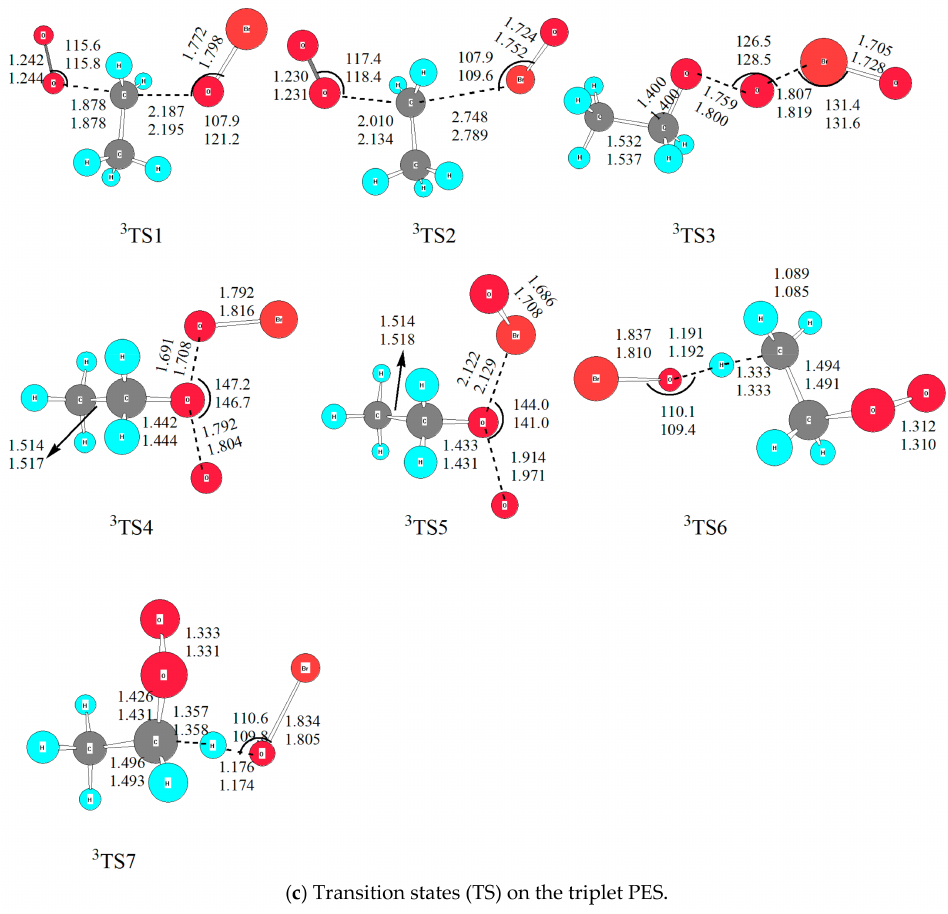
Figure 1. The optimized geometries for all species in the C 2 H 5 O 2 + BrO reaction at B3LYP/6-311++G(d,p) and B3LYP/6-311++G(2df,2p) levels. Bond distances are in Å and bond angles are in degrees. The upper one is from B3LYP/6-311++G(2df,2p); and the lower one is from B3LYP/6-311++G(d,p). ( a ) reactants and products; ( b ) intermediates (IM) and transition states (TS) on the singlet PES, with the bottom data is from M062X/6-311++G(2df,2p); ( c ) transition states (TS) on the triplet